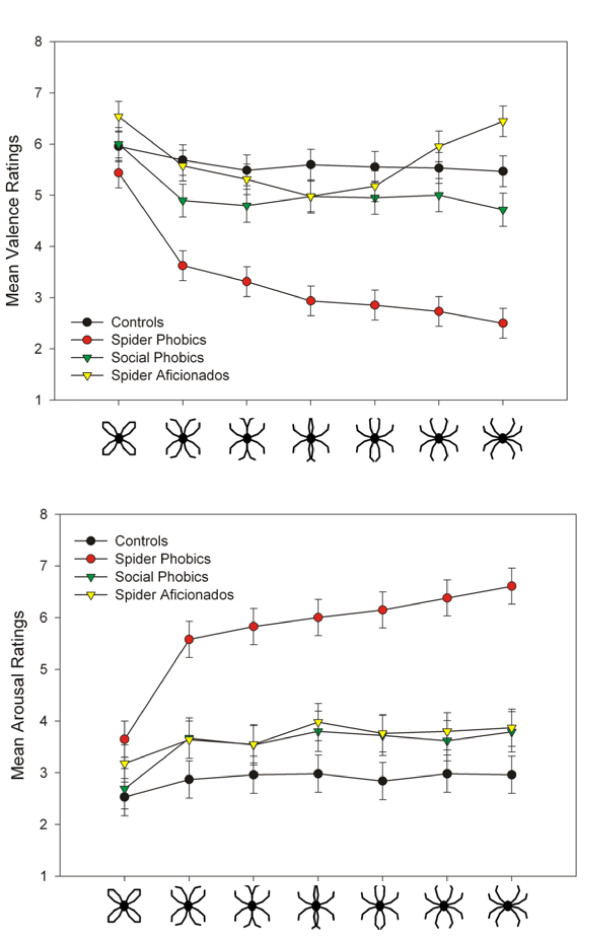
Valence and arousal ratings. Mean valence (upper row) and arousal ratings (lower row) and standard errors for the series of schematic spider/flower pictures for each group. Note. The SAM scale (Lang, 1980; Bradley & Lang, 1994) ranged from 1 to 9 with 1 = highly unpleasant/low arousing and 9 = highly pleasant/highly arousing.